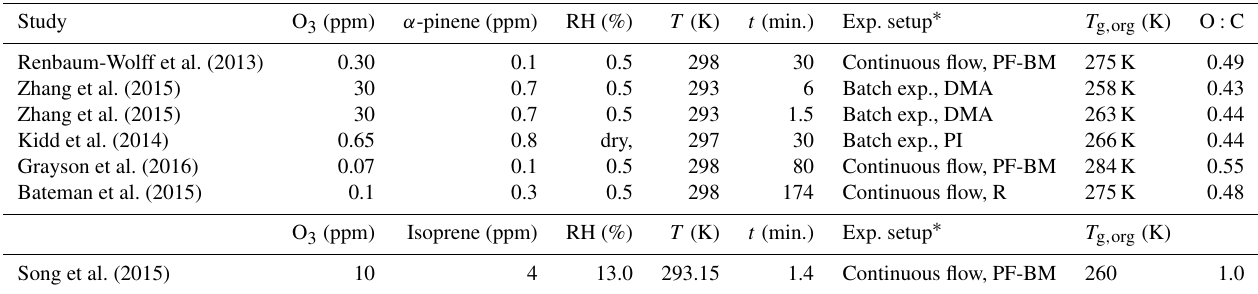
Table 1. Experimental conditions simulated in the box model to explore α -pinene and isoprene SOA viscosity, as well as simulated glass transition temperatures of dry SOA ( T g , org ) and the O : C ratio.